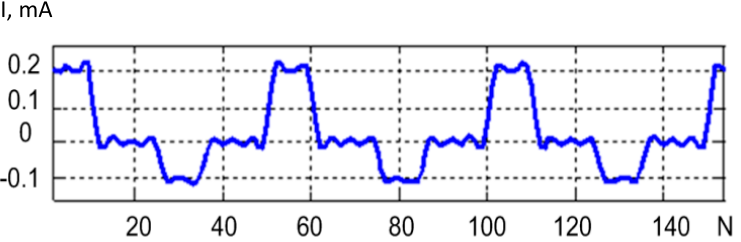
Figure 13. Noise suppression using a 9th order Type I Chebyshev filter with a cutoff frequency of 330 kHz.